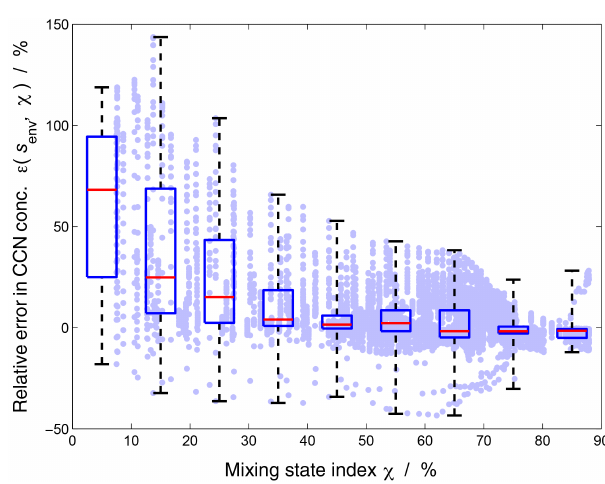
Figure 6. Relative error (cid:15)(s env ,χ) for each individual aerosol popu- lation in P (light purple dots), evaluated for 20 supersaturation val- ues between 0.05 and 1%; see Eq. (2) for definition. The boxes show the 25th and 75th percentiles of the distribution of relative er- rors in each χ bin. The red line is the median of that distribution, and the dashed line extends to the minimum and maximum errors.